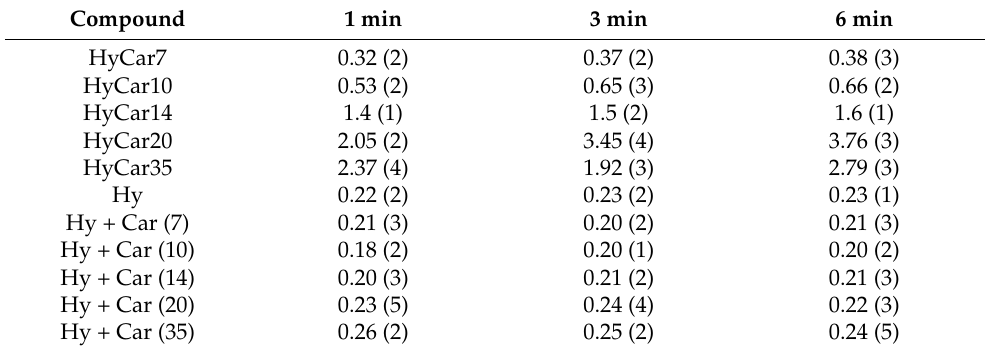
Table 1. TEAC values for all the HyCar derivatives and for the corresponding mixtures containing equivalent amounts of the parent compounds (Hy and Car). Car (x) means carnosine whose concentration is the same in the corresponding conjugate HyCar (x). Numbers in parentheses represent the statistical error (SD).